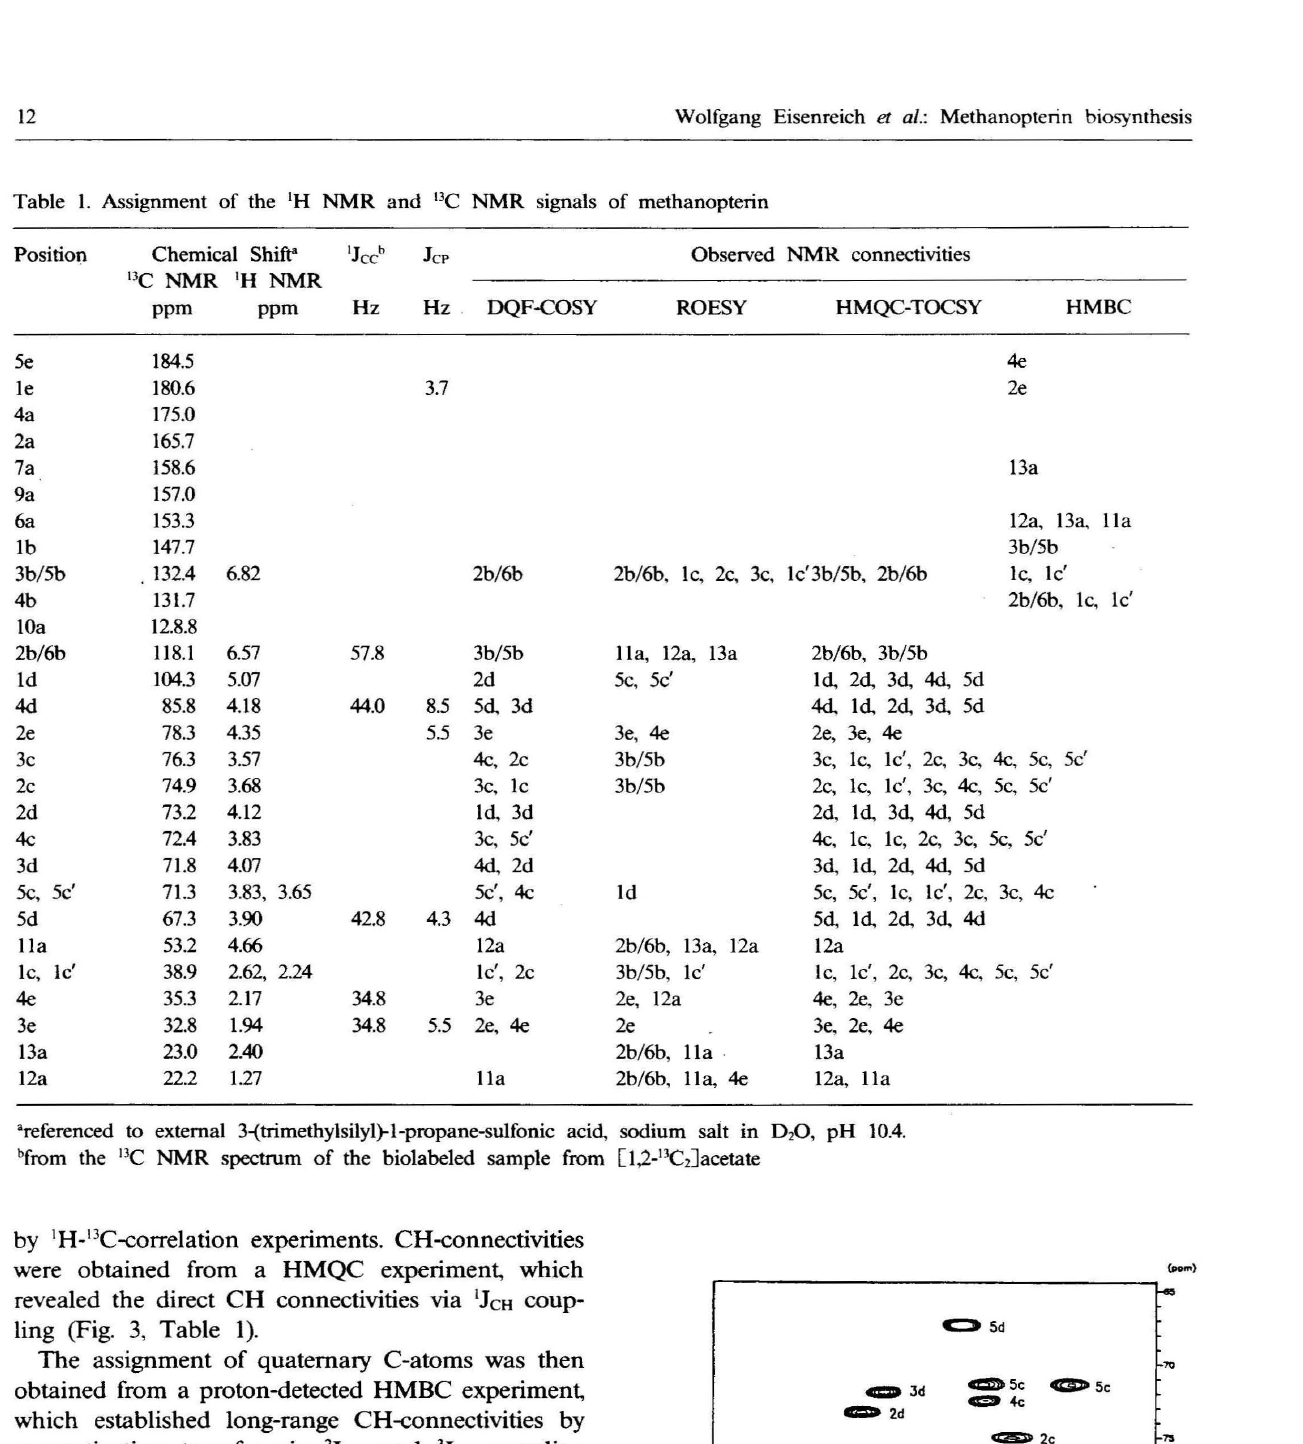
Table I. Assignment of the 'H NMR and IJC NMR signals of methanopterin Positioi1